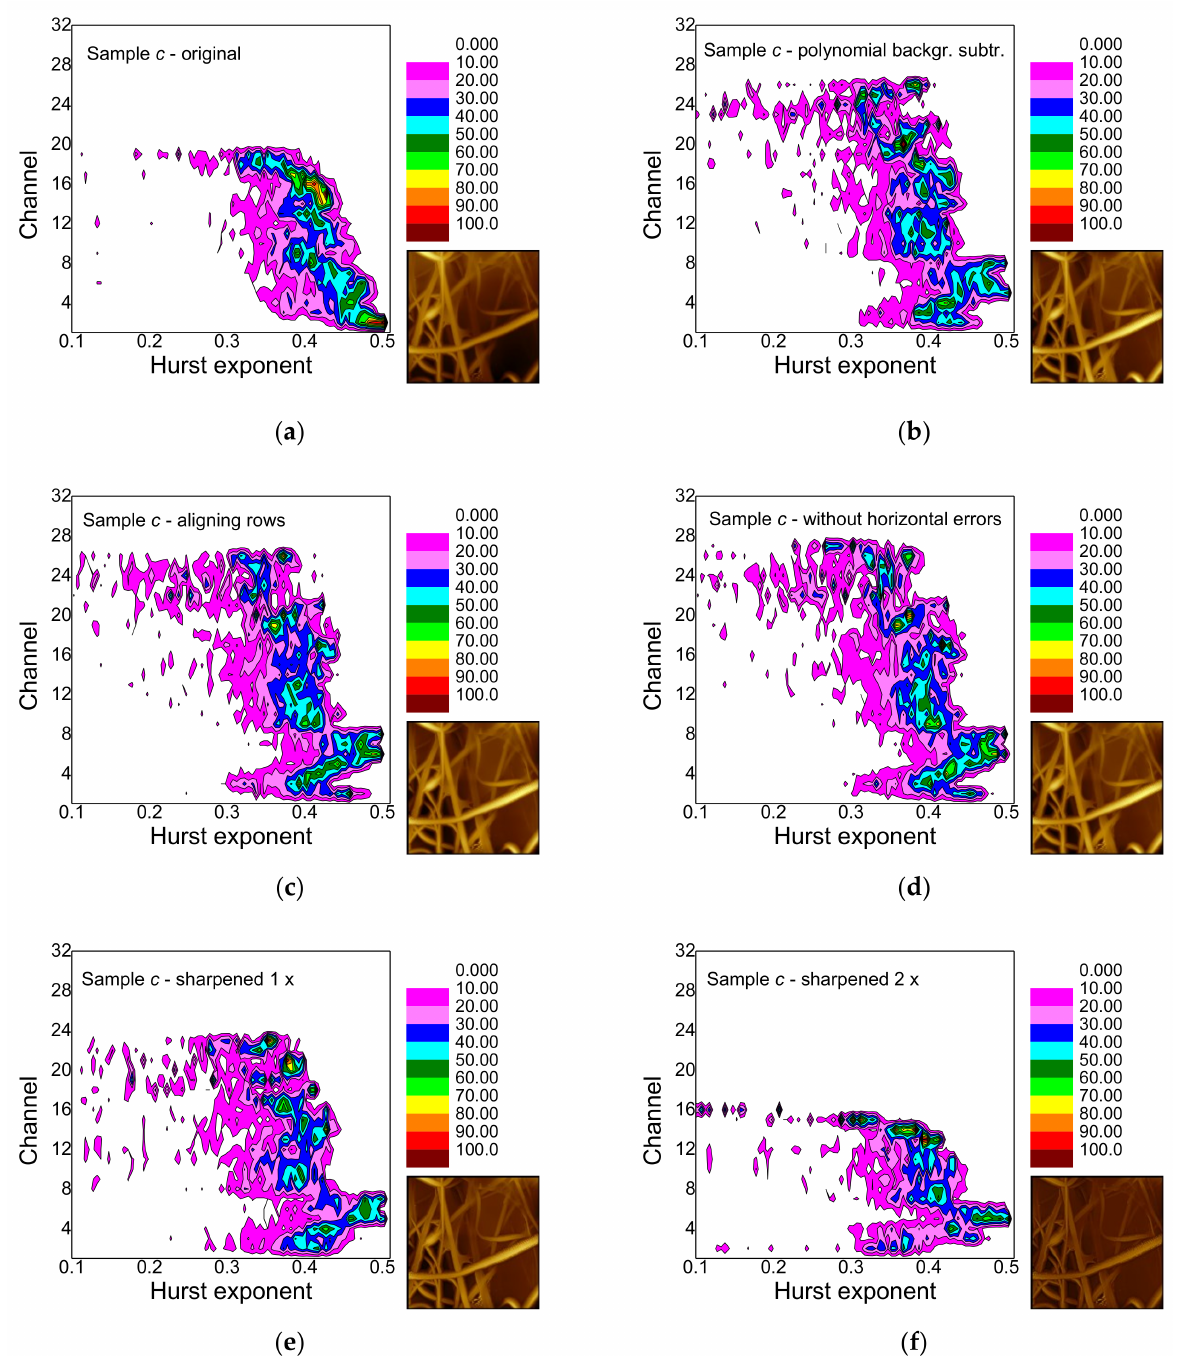
Figure 8. Gray-scale-resolved Hurst exponent distribution of sample c : ( a ) original; ( b ) after polynomial background subtraction; ( c ) after aligning rows; ( d ) after deleting horizontal errors; ( e ) after sharpening; ( f ) after sharpening